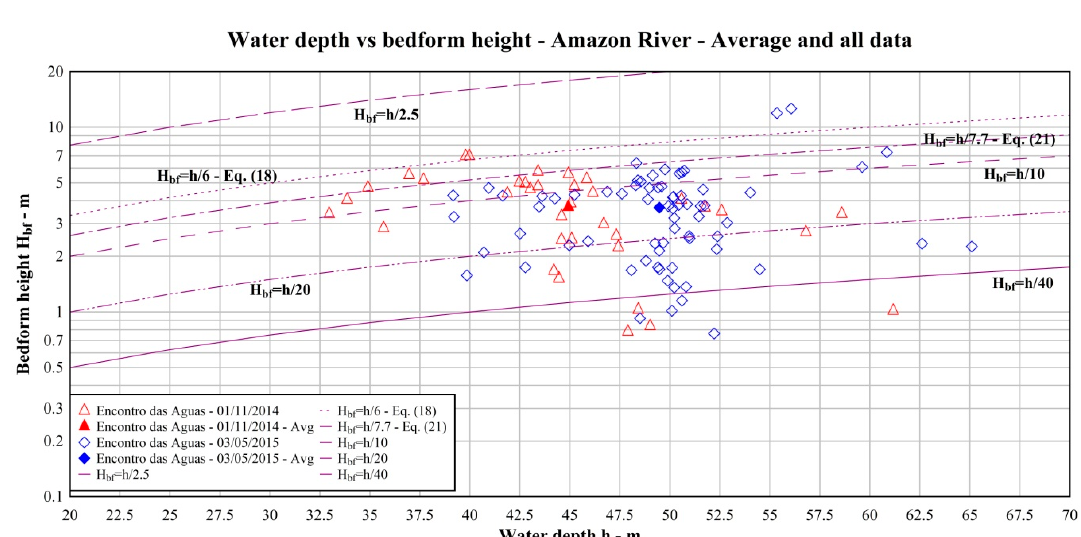
Figure 15. Bedform wave heigth vs. water depth.